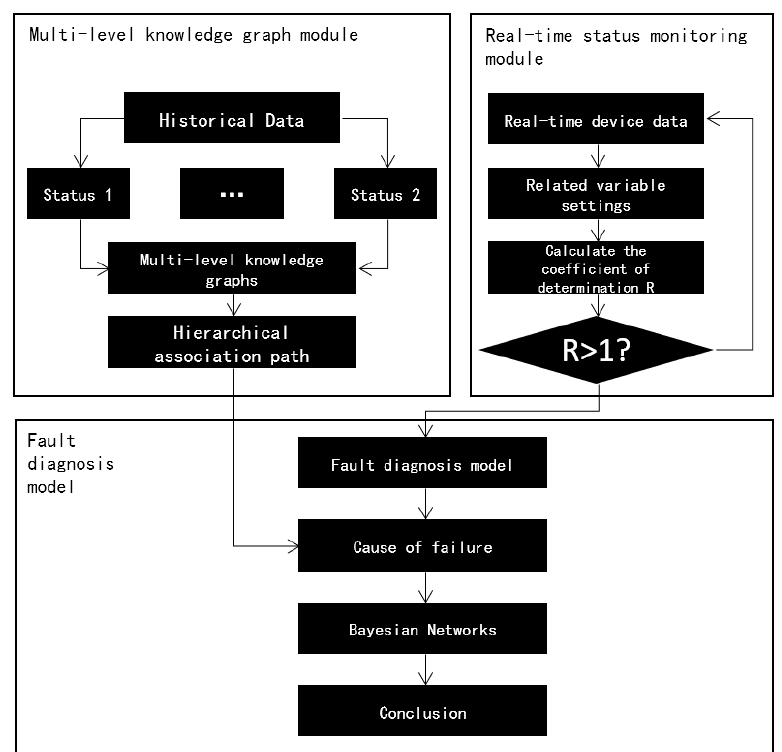
Figure 6. Knowledge Graph Application Algorithm Process.